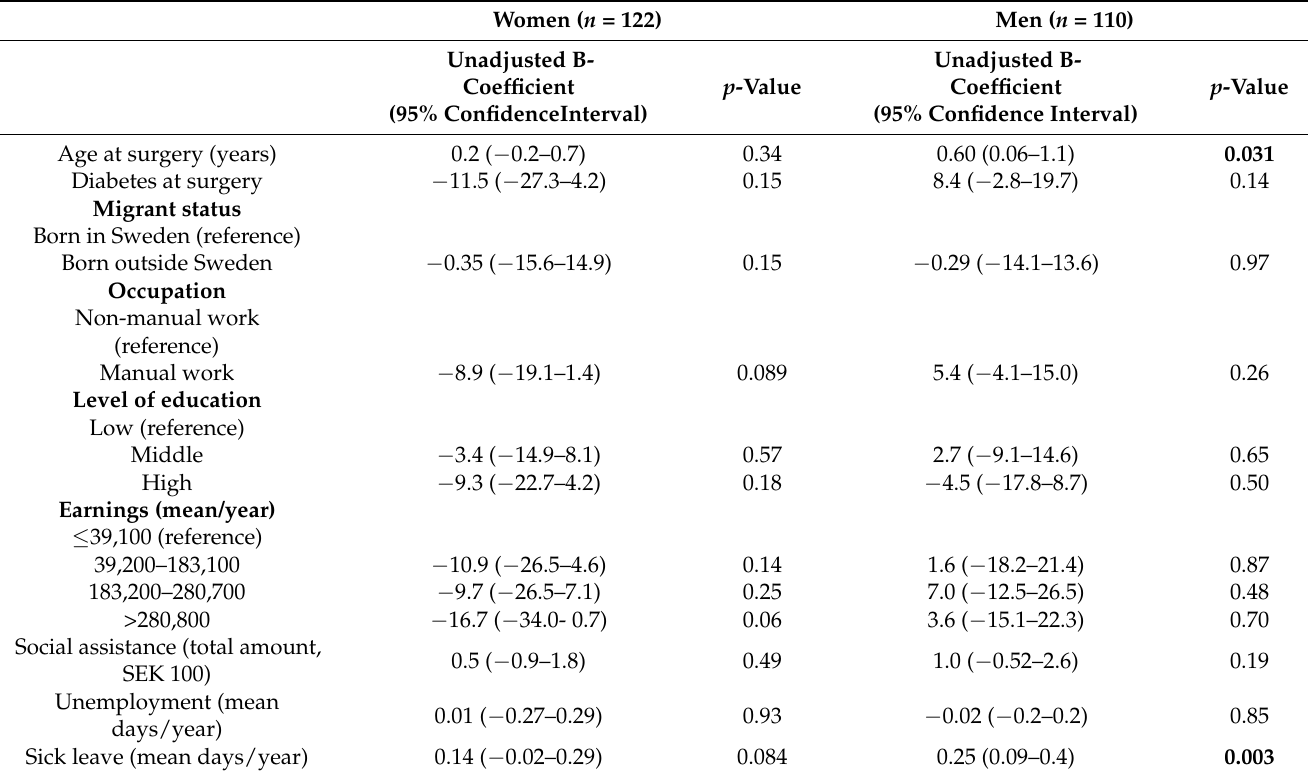
Table 4. Linear regression for patients with surgically treated ulnar nerve entrapment at the